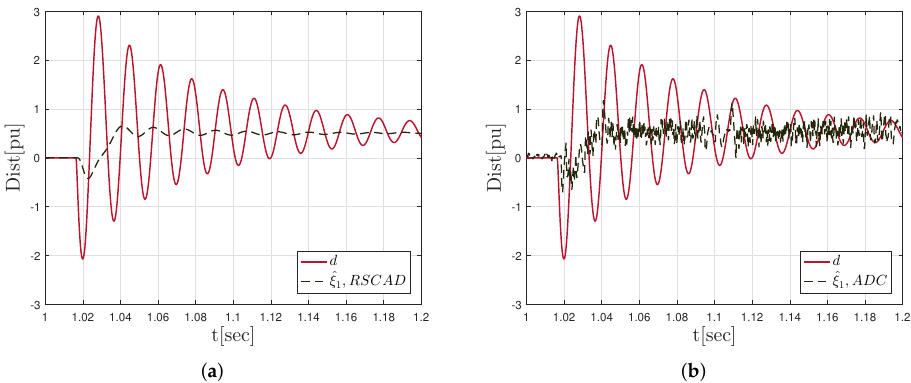
Figure 9. Fixed-gain IMDOB estimation performance degradation due to measurement noise. ( a ) fixed-gain IMDOB estimation using RSCAD data; ( b ) fixed-gain IMDOB estimation using ADC data.